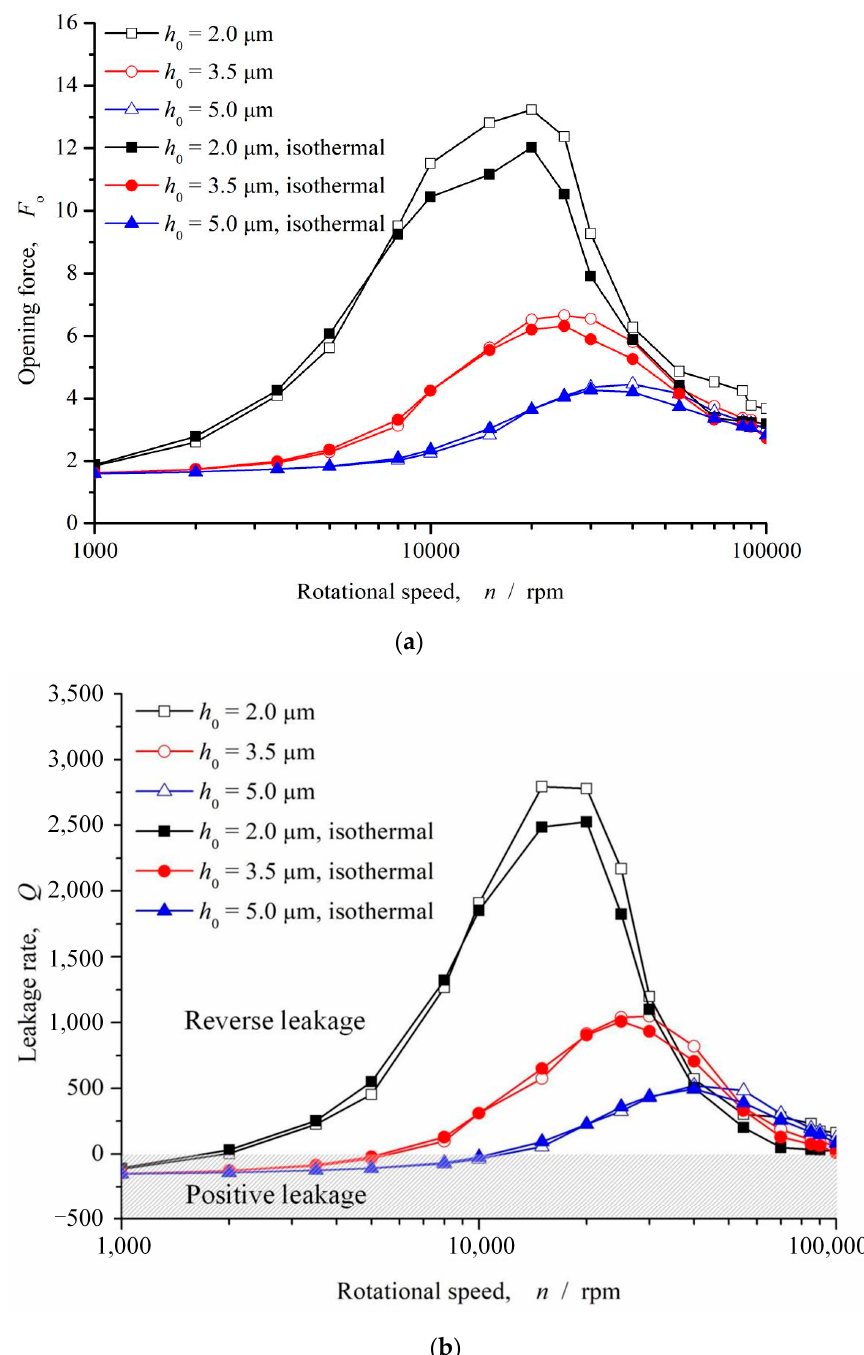
Figure 7. Influence of rotational speed on opening force and leakage rate ( P o = 4, h 0 = 2 µ m, h d = 5 µ m, b = 0.20 mm, γ = 3, α = 45°, N = 80). ( a ) Opening force; ( b ) Leakage rate.